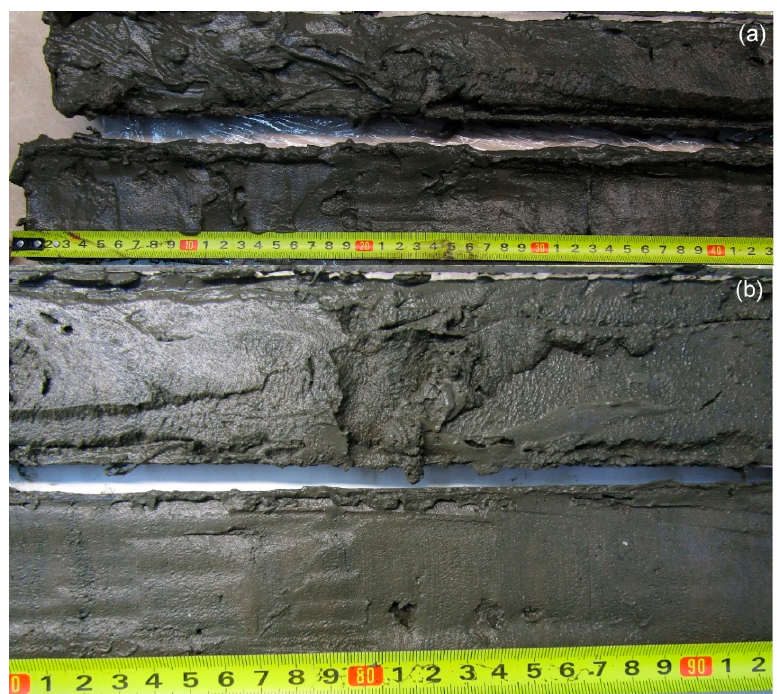
Figure 4. Holocene lacustrine sediments: ( a ) upper part of Holocene sediments. ( b ) middle part of Holocene sediments. Diagenetic banding can be seen at the bottom of the unit. Lithological unit 1, c о re ONG-2.